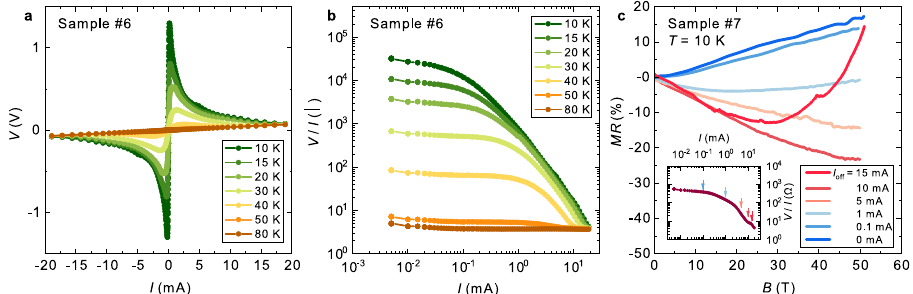
Fig. 5 | Current switching of the topological phase in α -(BETS) 2 I 3 . a Current – voltage ( I – V ) characteristic of Sample #6 measured at several tem- peratures using the four-terminal dc method with constant currents. A nonlinear conduction effect is observed in the wide current range. b Current dependence of the sample resistance ( V / I ). In the low current region, V / I is a constant value fol- lowed by Ohm ’ s law. As the applied current increases, the sample resistance